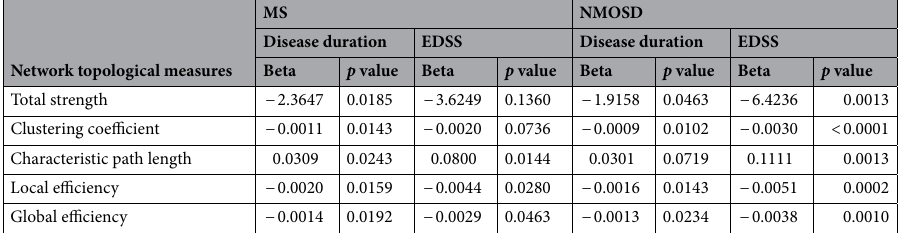
Table 3. The associations between global network measures and clinical parameters (disease duration and EDSS) in the MS and NMOSD groups. MS multiple sclerosis, NMOSD neuromyelitis optica spectrum disorders, EDSS expanded disability status